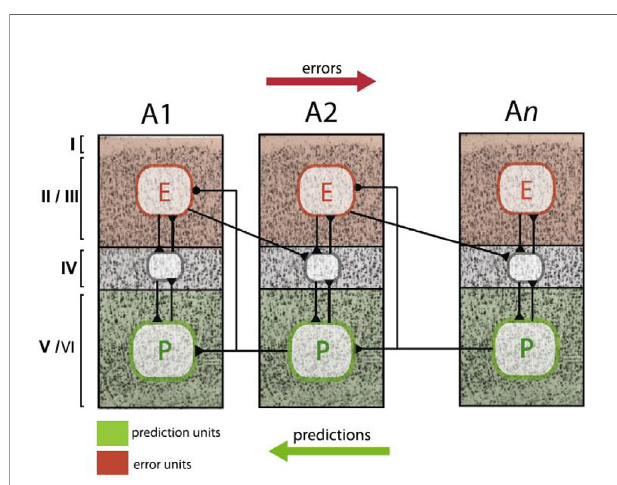
FIGURE 5 | Schematic summary of proposed neurophysiological implementations of hierarchical Bayesian inference in the cortex, speci fi cally, predictive coding. In this scheme, neurons that compute prediction errors (red plates, E) are situated in supragranular layers and signal these errors to neurons in granular layers (grey plates) at the next higher level. By contrast, neurons that compute predictions (green plates, P) are lcoated in infragranular layers and signal these predictions to neurons in both infra- and supragranular layers at the next lower level. This fi gure is reproduced, with permission, from Heilbron and Chait